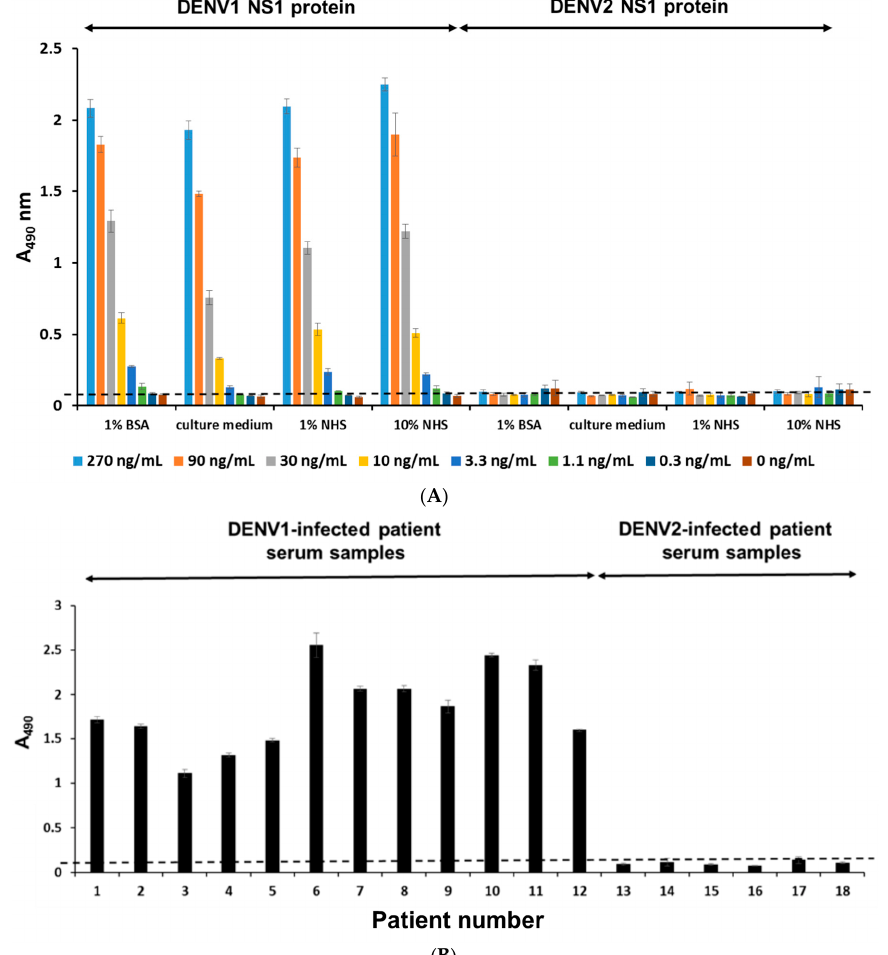
Figure 5. Serotyping specificity of DENV1 NS1 diagnostic platform. ( A ) DA15-3 was coated in